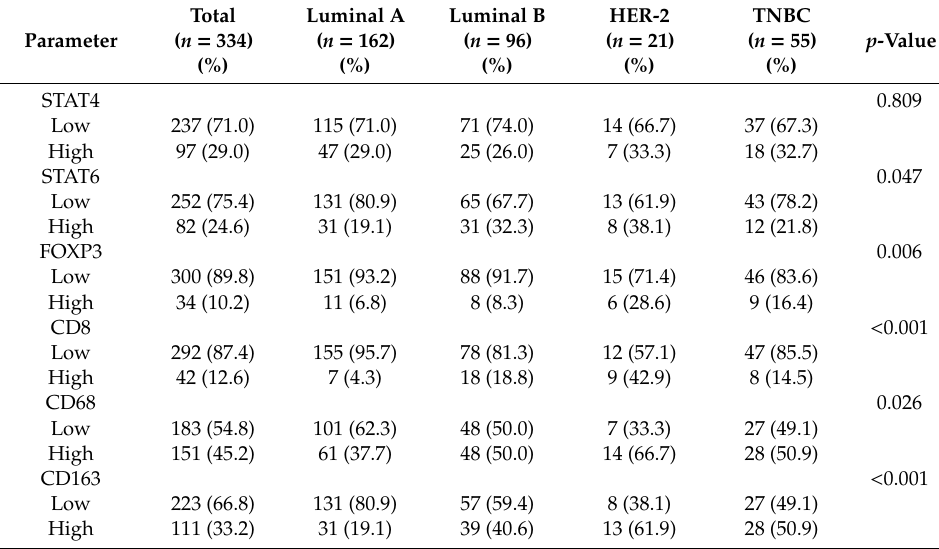
Figure 1. Representative images of immune cell subtype-related protein expression according to the breast cancer molecular subtypes. TNBC, triple-negative breast cancer. Table 1. Expression of immune cell subtype-related proteins according to the breast cancer molecular subtype (Low versus